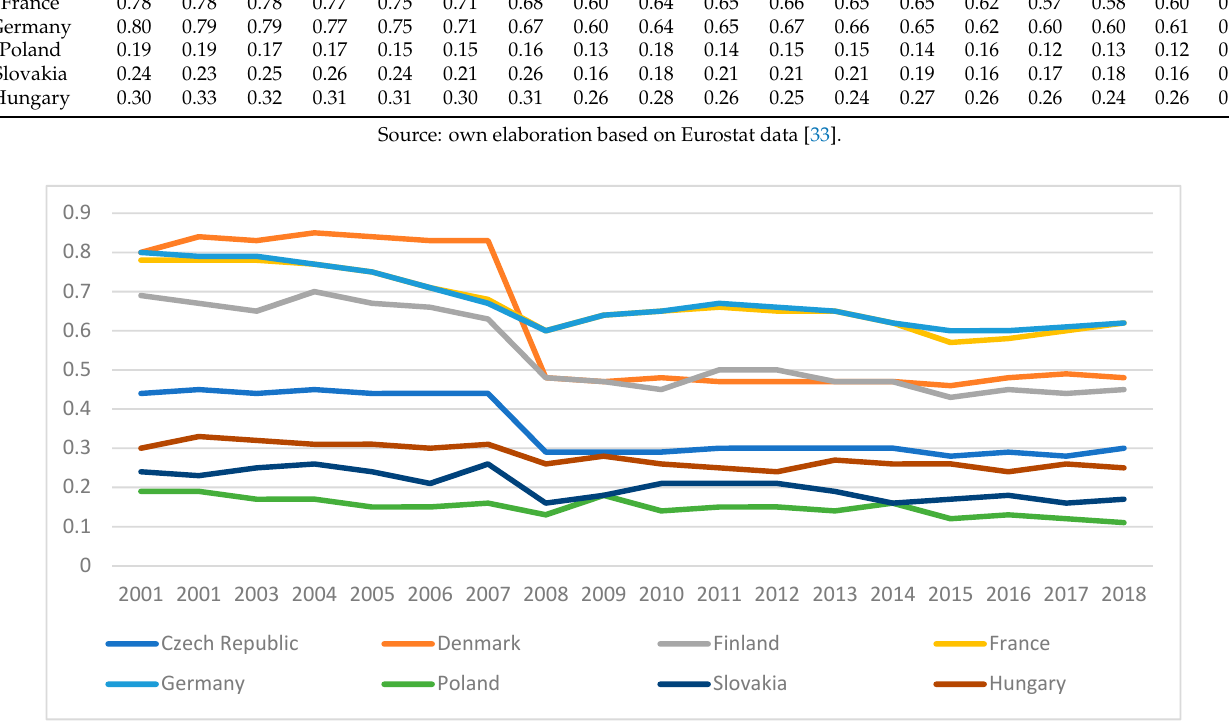
Table 2. Values of the synthetic indicator of the level of economic development in the studied EU countries in 2001–2018. Country/Year 2001 Czech Rep. Energies 2021 , 14 , x FOR PEER REVIEW